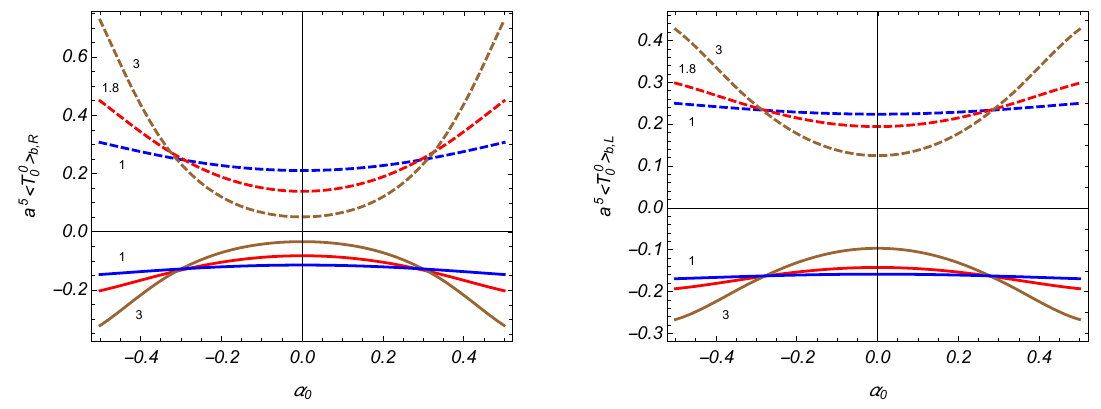
Figure 4 . The brane-induced energy density as a function of the parameter α 0 . The left and right panels correspond to the R- (with w/w 0 = 1 . 5) and L- (with w/w 0 = 0 . 75) regions and the numbers near the curves are the values for q . The full and dashed curves are plotted for s = +1 and s = respectively, and for ma = 1, r/w 0 = 0 .